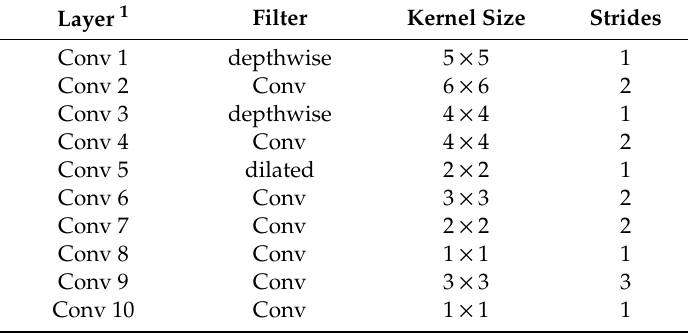
Table 1. The detailed parameters of segmentation networks.